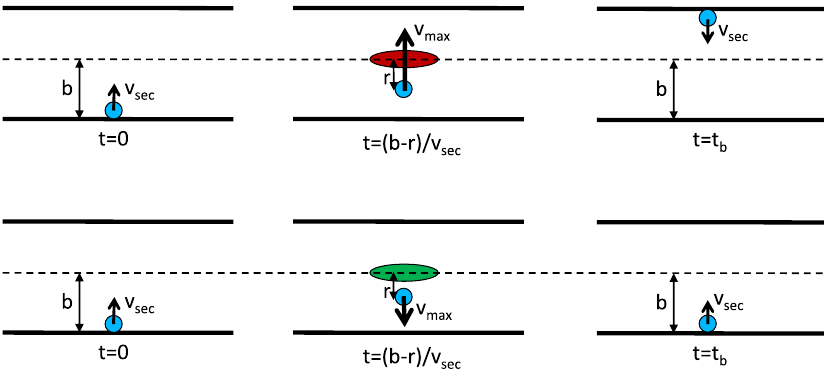
FIG. 4. Diagram of single bunch multipacting resonances: positron beams (top) and electron beams (bottom). A secondary electron is released from the bottom wall (left), travels upward at speed v , receives a kick from a passing bunch (middle), and hits the wall, sec releasing another secondary electron at time t ¼ t b (right).